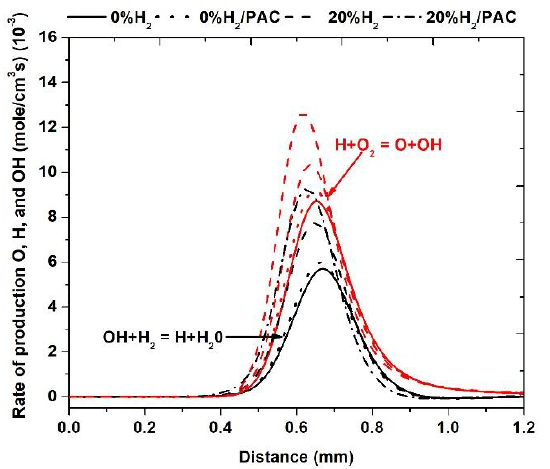
Figure 11. Rate of production of O, H, and OH with different blends of hydrogen without or with NSPD.